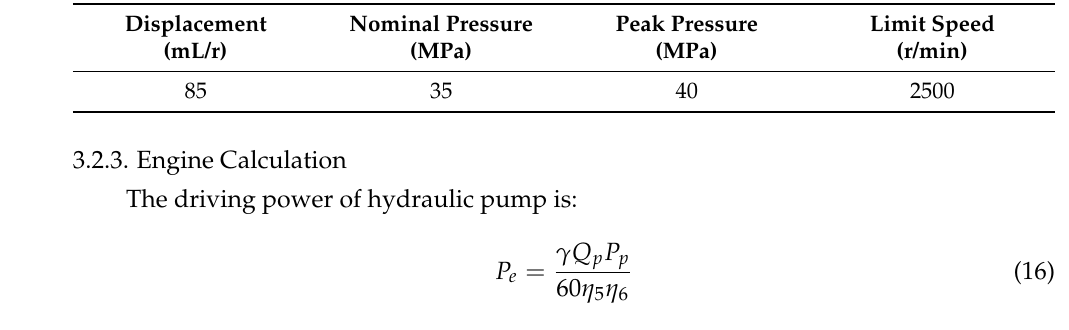
Table 3. Main parameters of hydraulic